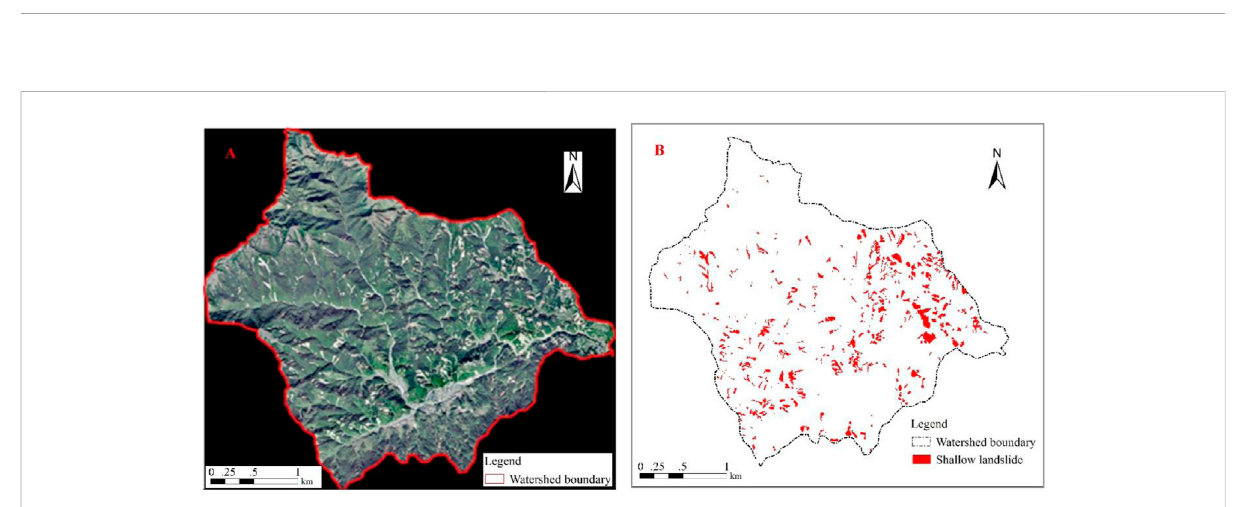
FIGURE 2 Distribution of shallow landslides in the Shenshui watershed induced by typhoon Fanapi. (A) Remote-sensing images after the event and (B) distribution of shallow